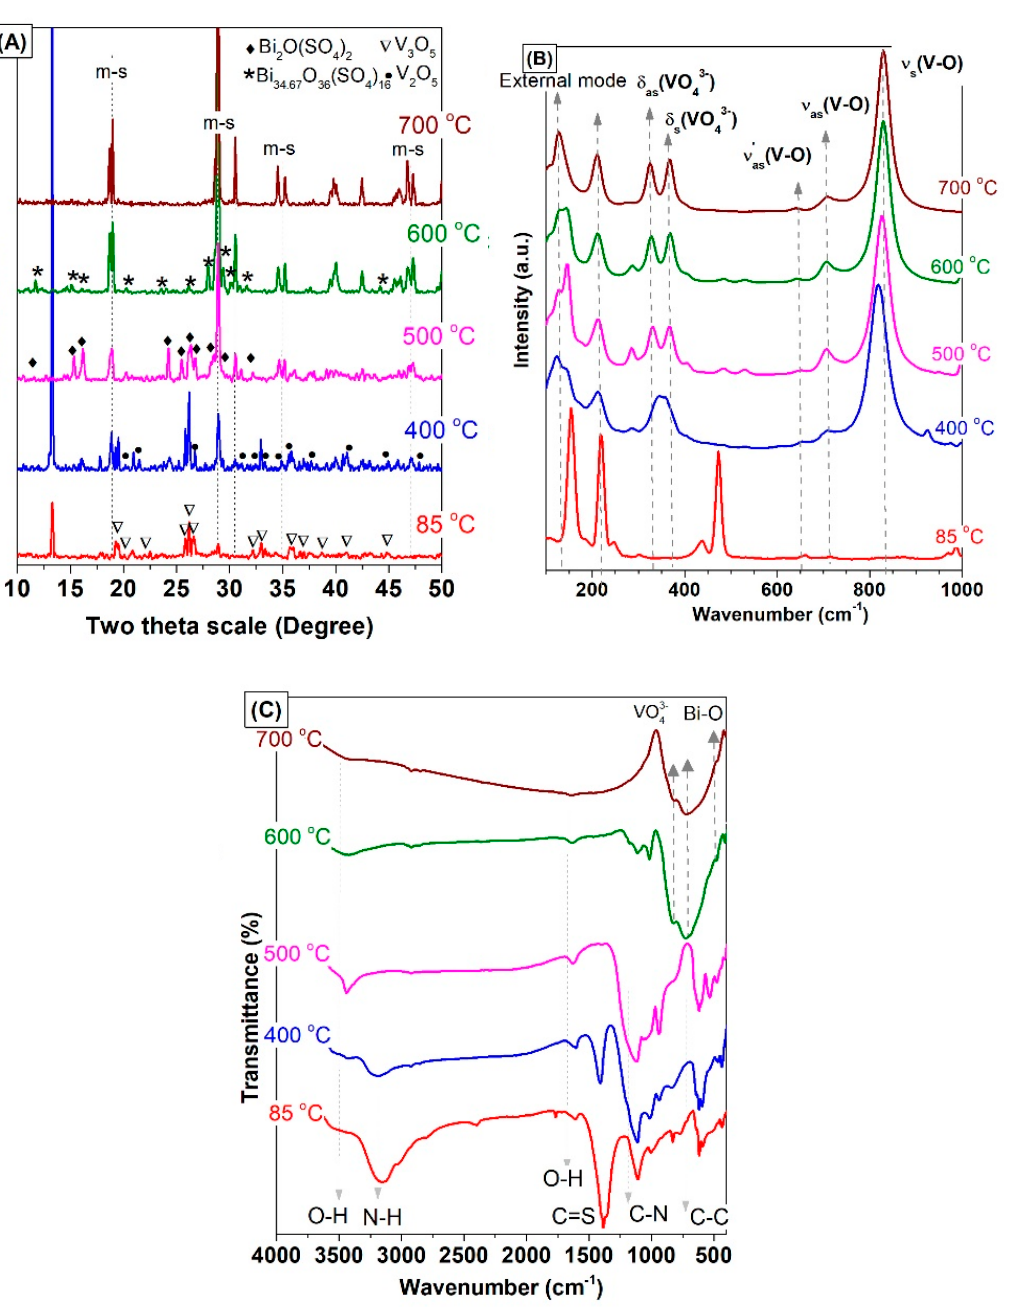
Figure 5. XRD pattern ( A ), Raman spectra ( B ), and FT-IR spectra ( C ) of the BiVO4 amorphous (85 °C) and sulfate-modified BiVO 4 annealed at 400, 500, 600, and 700 °C.